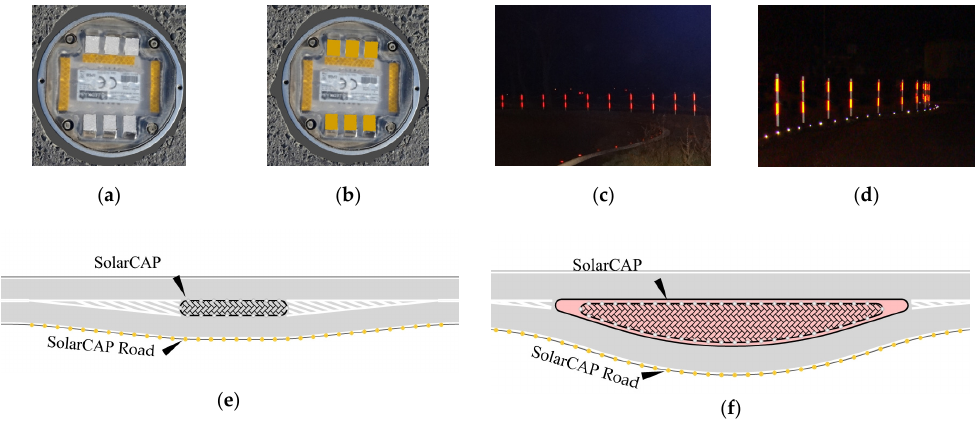
Figure 25. Recommended use of the latest solar technology: ( a ) SolarCAP mounted in the face of the island kerb–white; ( b ) SolarCAP Road installed in the outer edge of the road–yellow; ( c ) red LED lights used in exceptional cases on guide posts placed behind the outer edge of the road; ( d ) recommended yellow LED lights mounted on guide posts placed behind the outer edge of the road in a forest terrain; ( e ) proposed layout of Solar CAP and SolarCAP Road elements placed on a rectangular central island horizontally deflecting one lane; ( f ) proposed layout of Solar CAP and SolarCAP Road elements installed on a semi-circular central island horizontally deflecting one lane.